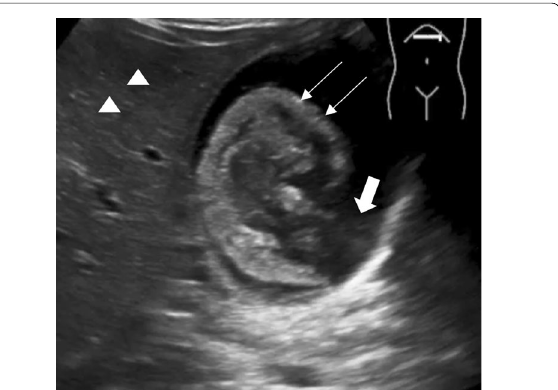
Fig. 3 Gall bladder sludge: Gall bladder sludge (long thin arrows), which appears as low‑amplitude homogeneous echoes, layering (thick arrow) on the posterior wall of the gall bladder with posterior acoustic enhancement due to change in reflective surface. The liver parenchyma (arrowheads) can be seen on the superior aspect of the acoustic window